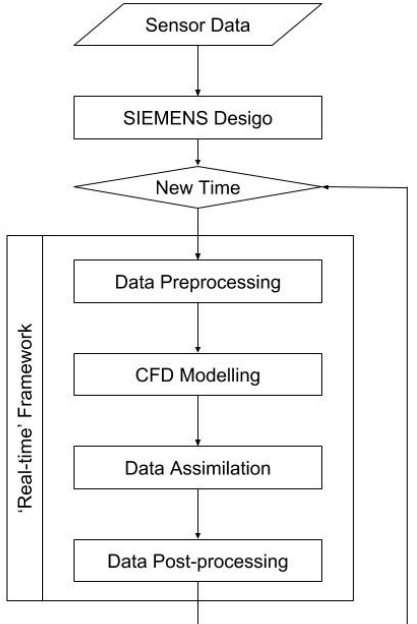
Figure 2. Diagram of calculation procedure for real-time computational fluid dynamics (CFD) modeling.